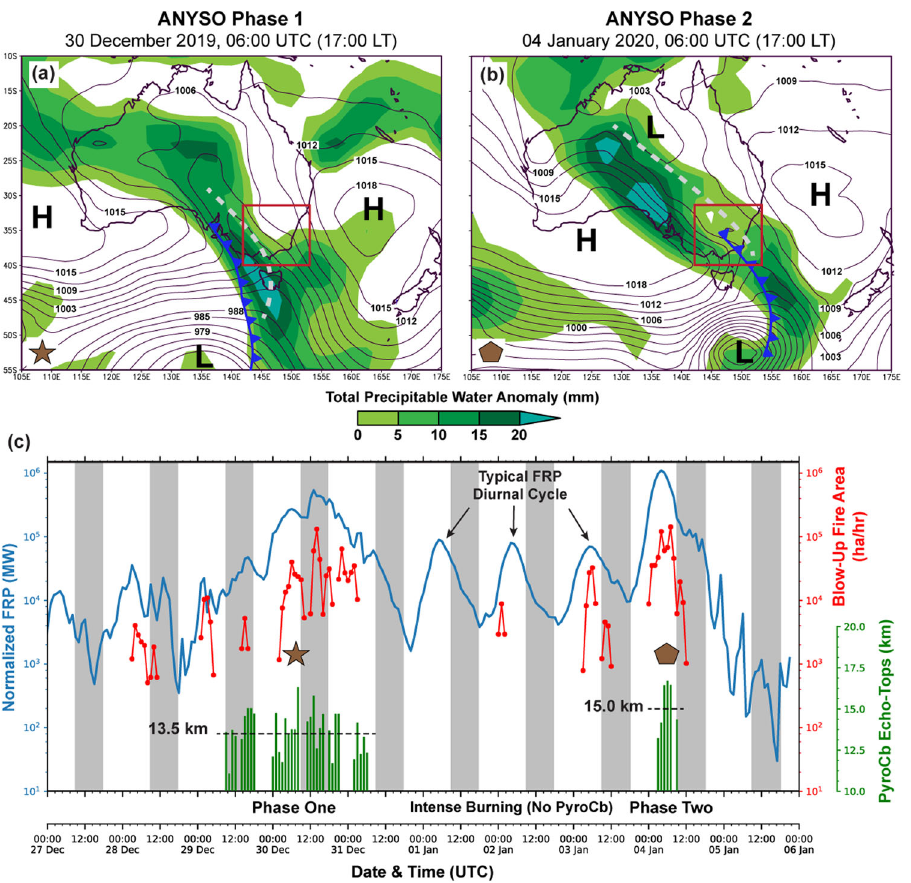
Fig. 6 Meteorology driving ANYSO pyroCb activity, regional fi re activity, and timing. Maps in a and b display the primary synoptic weather features as both phases of pyroCb activity reached maximum intensity, with cold fronts displayed in blue and prefrontal troughs in dashed gray. Green shading indicates positive anomalies of total column precipitable water derived from the 30-year (1981 – 2010) NCEP/NCAR climatology. Mean sea level pressure is displayed in black contours. Red box indicates the region with active wild fi res and pyroCb development analyzed in the hourly time series ( c ). Normalized FRP from AHI is plotted in blue. The area burned per hour by active blow-up fi res is plotted in red. Maximum pyroCb echo-tops are plotted in green, with the approximate tropopause altitude represented as a dashed black line. Symbols coincide with the timing of the synoptic weather maps in a and b